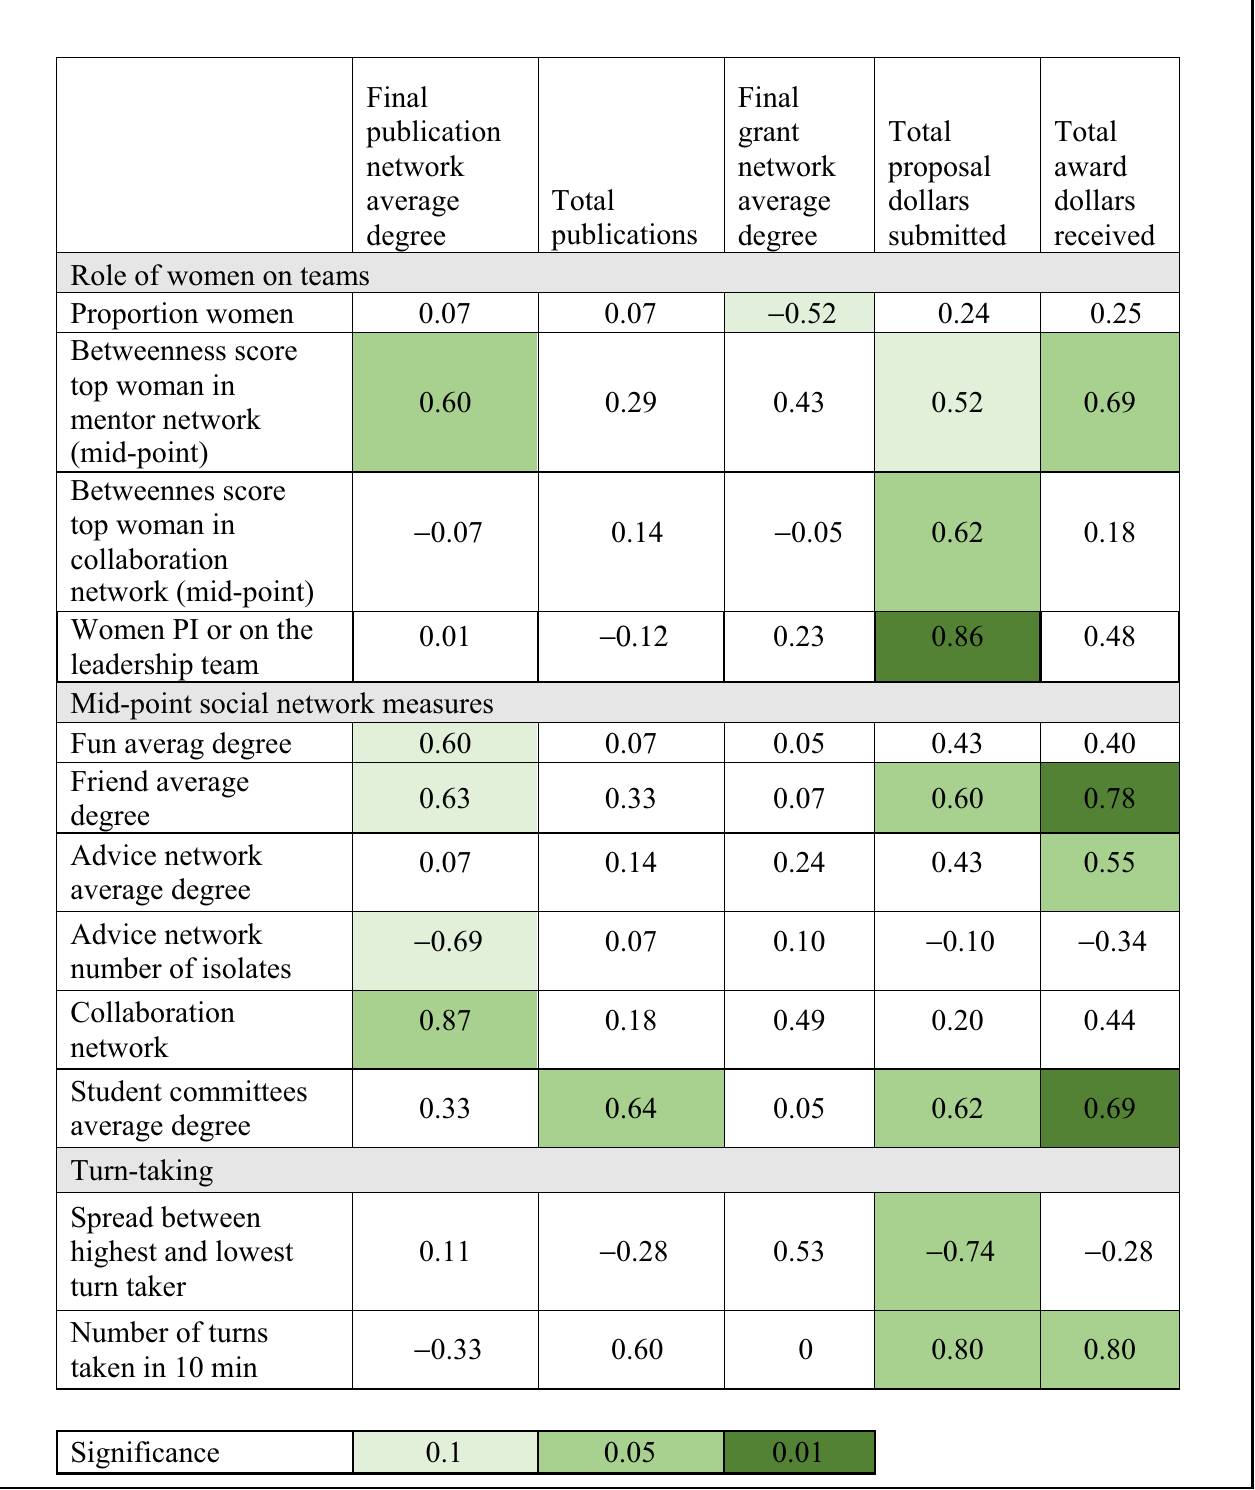
Table 2 Rank correlation highlights important team